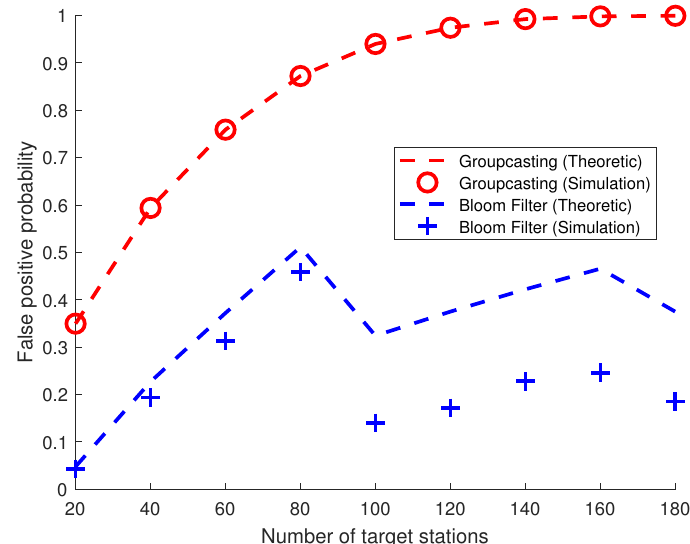
Figure 8. False positive probability given that the station is not the station to be woken